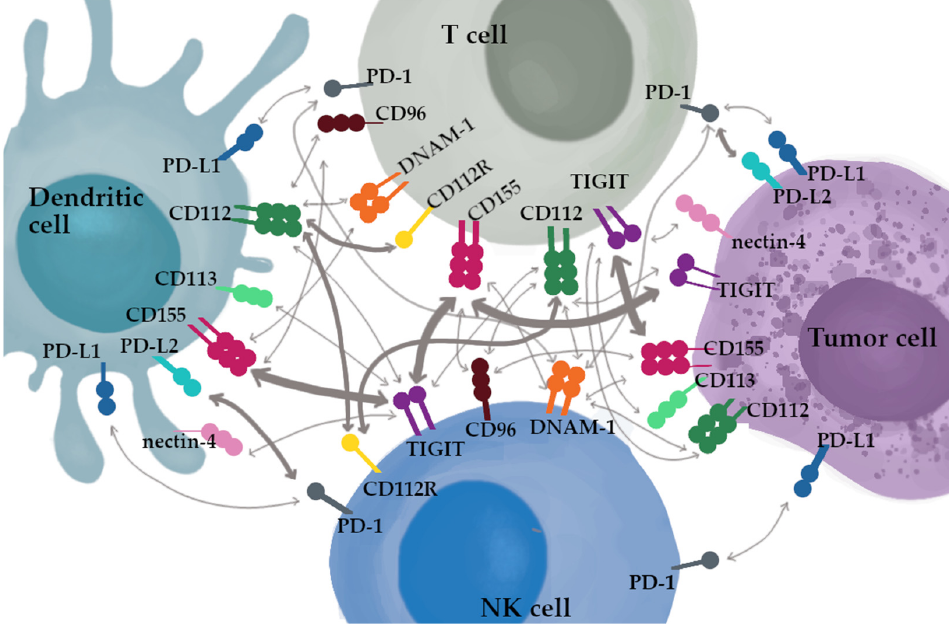
Figure 2. The net of TIGIT/CD155/DNAM-1 signaling. The thickness of the arrows represent the reported affinities.